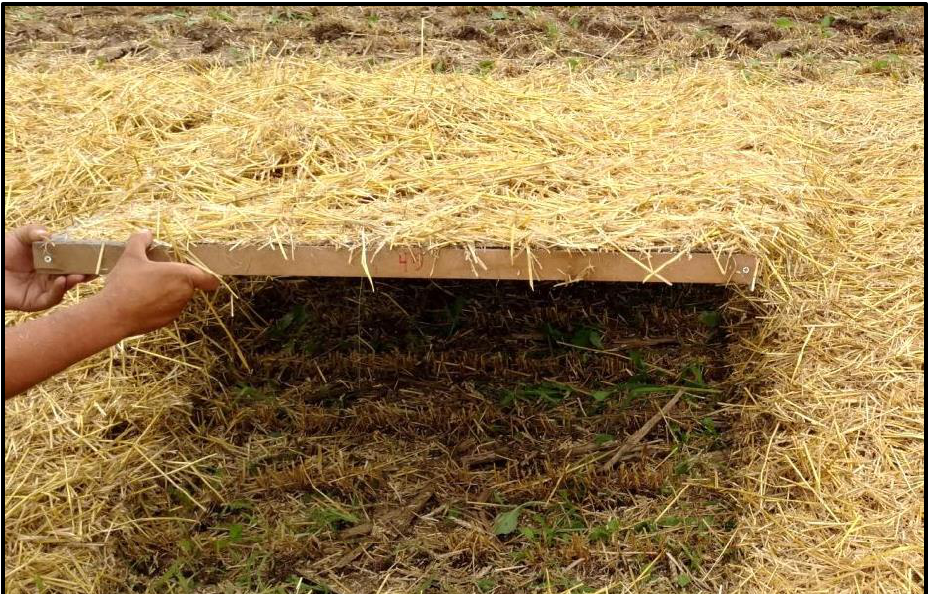
Figure 5. Sample collection where screens were placed on the ground as the combine passed so residue was collected before it landed on the ground.